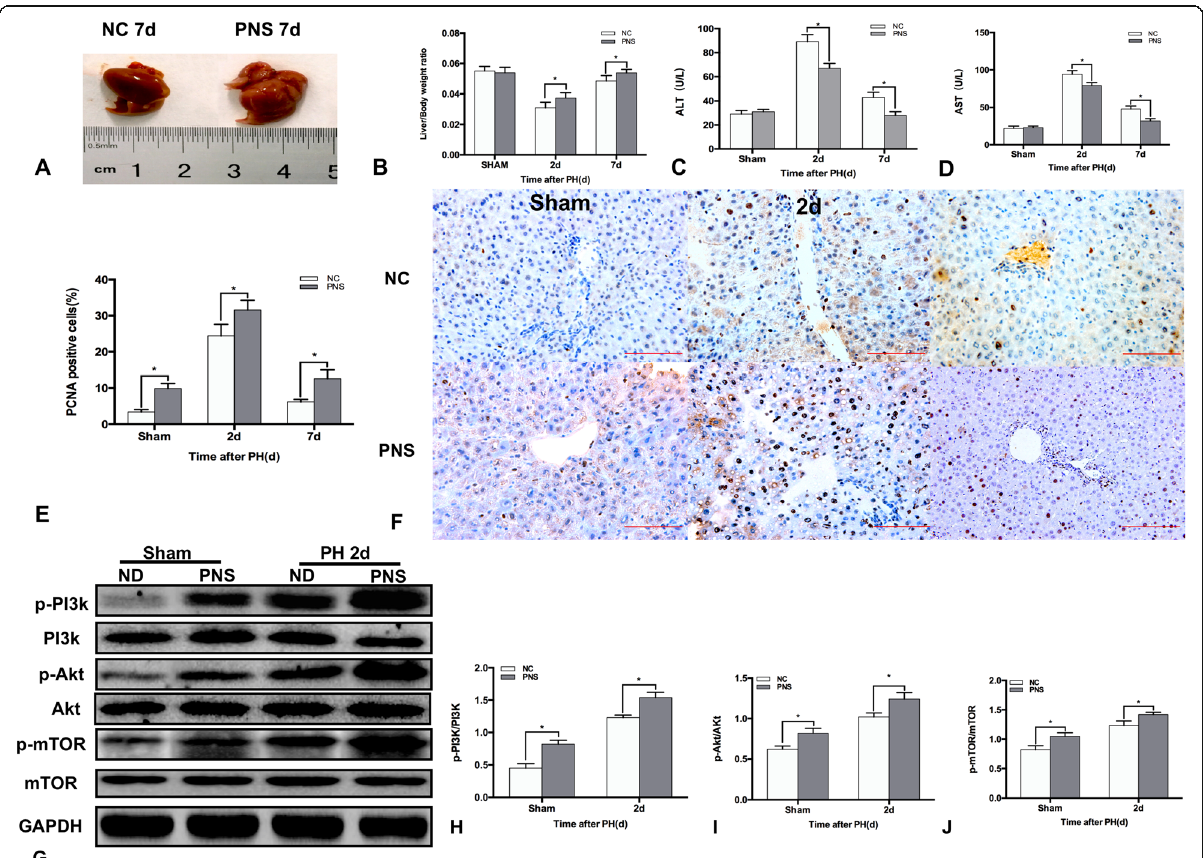
Fig. 2 PNS activated the PI3K/AKT/mTOR signaling pathway during LR in vivo. C57BL/6 J mice were administered PNS 7 days before PH. ( a ) The regenerated liver in mice treated with or without PNS 7 days after PH. ( b ) Quantification of the relative ratio of liver weight/body weight in mice treated with or without PNS at 2 d and 7 d after PH. Serum concentrations of ALT ( c ) and AST ( d ) at 2 d and 7 d after PH. ( e ) Quantification of PCNA-positive cells in mice treated with or without PNS at 2 d and 7 d after PH. ( f ) Representative liver sections stained with PCNA in mice treated with or without PNS at 2 d and 7 d after PH (original magnification: × 200, scale bars represent 100 μ m). ( g ) Total and phosphorylated protein levels of PI3k, AKT and mTOR in mice treated with or without PNS at 2 d after PH. (H)(I)(J) Bar graph shows the quantification of the total and phosphorylated protein levels of PI3k, AKT and mTOR. Values represent the mean ± SD of at least three independent experiments. * P<